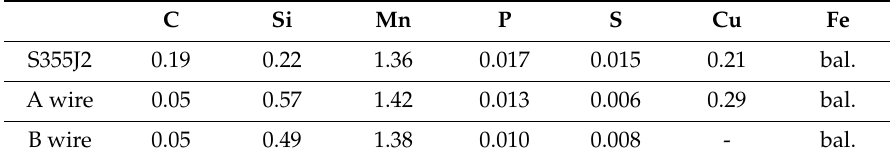
Table 1. Chemical composition in percentage by weight (wt.%) of the base material and weld metal made with the use of wires according manufacturers certificates. C Si Mn P S